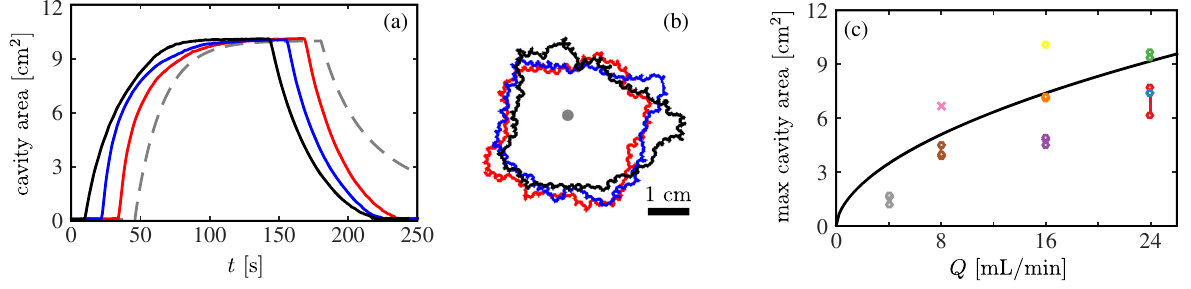
FIG. 2. Fluid injection into the center of the packing drives outward compaction, opening a cavity. When injection stops, the packing relaxes and the cavity closes. (a),(b) Here, we inject at a steady rate of Q ¼ 16 mL = min for about 135 s and then stop, allowing the packing to relax. We repeat this injection-relaxation cycle two more times (black, then blue, then red). (a) Comparing the area-versus- time curves from the three cycles (offset by 12 s for comparison; cf. Fig. 7) shows that the process is macroscopically smooth, with similar dynamics and maximum area in each cycle. The first cycle (black) is somewhat different from subsequent cycles due to heterogeneities in the initial particle distribution. We also show the prediction of a continuum model using best-fit material properties (dashed gray curve); we discuss the model in Sec. V. (b) The steady-state cavity shape is neither smooth nor repeatable, indicating the presence of irreversible micromechanics. The cavity does not open symmetrically about the injection port (gray circle with diameter ∼ 2 . 5 mm). The scalloped edges of the cavity profiles are particle-scale roughness ( ∼ 1 mm). (c) We repeat this experiment at different injection rates, showing here the maximum (i.e., steady-state) cavity area against injection rate Q . Each group (color) of circles indicates a series of at least two cycles after “ resetting ” the packing by removing the particles, cleaning the apparatus, and replacing the same particles (the cross is a single cycle). The variability between cycles is relatively small except in one case (red), indicating that cycle-to- cycle irreversibilities have a weak impact on the macroscopic mechanics. The variability between series at the same injection rate is much larger, indicating that the particle arrangement has a strong impact on the macroscopic mechanics. All packings have initial porosity between 0.506 and 0.515, and we do not observe any clear correlation between initial porosity and cavity size in this range. The black curve is the prediction of the continuum model using the same mechanical properties for all